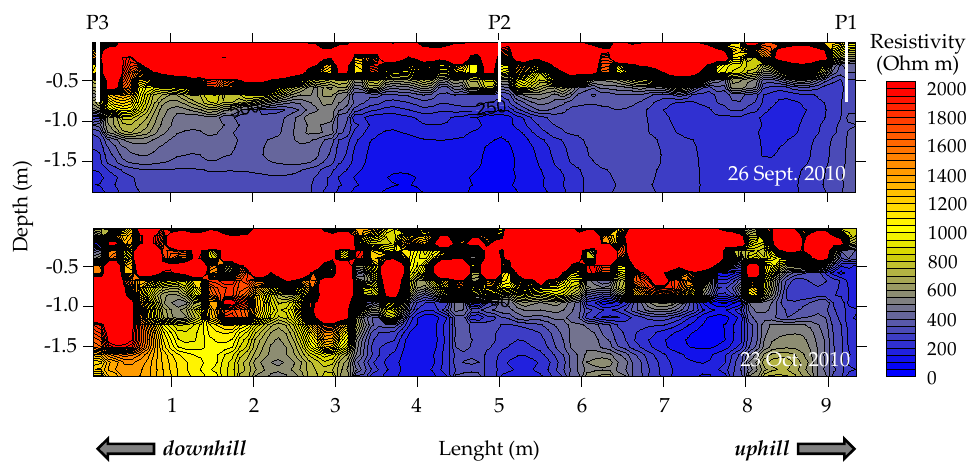
downhill Figure 16. Cogne site, 2010. ERT profiles acquired at the two survey dates along a short profile (see Figure 15 for location). The white lines identified by the P indicate the three 0.75 m depths TDR measurement points. Note that the resistivity scale is much larger in the ERT profiles than in the EMI maps, in order to give a clearer presentation of the variations of resistivity with depth. values—see Figure 15 for the transect identification—confirm the water content decrease in the upper layers where the resistivity is higher (as easily seen also in Figure 16) but a strong variability connected with the irregular micro morphology of each measurement point become evident. Table 2. Cogne site, 2010. TDR soil moisture values measured during the 26 September 2010 EMI and ERT monitoring campaigns. The two TDR transect alignments are depicted in Figure 15. Transect “P” Transect “S” Probe Code